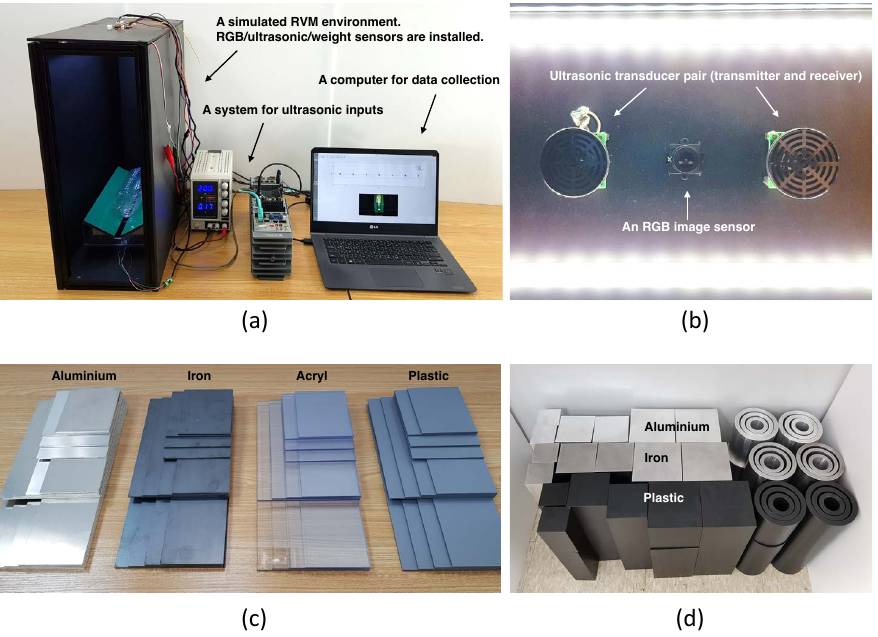
Figure 4. The hardware setup for data acquisition and raw materials used for the material database. ( a ) Overview of the setup. From left: the box for object placement, the power supply, the controller and the laptop. Ultrasonic, camera (RGB) and load cell sensors are attached to the box. ( b ) Inner- upper side of the box, where LED bars, ultrasonic transmitter/receiver and the camera sensor were attached. ( c ) Flat shapes and ( d ) cuboid and cylinder shapes.